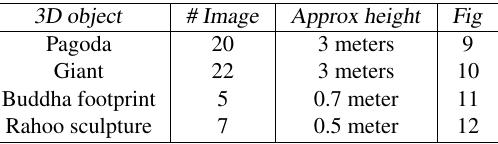
Table 1: Summary of 3D models presented in this